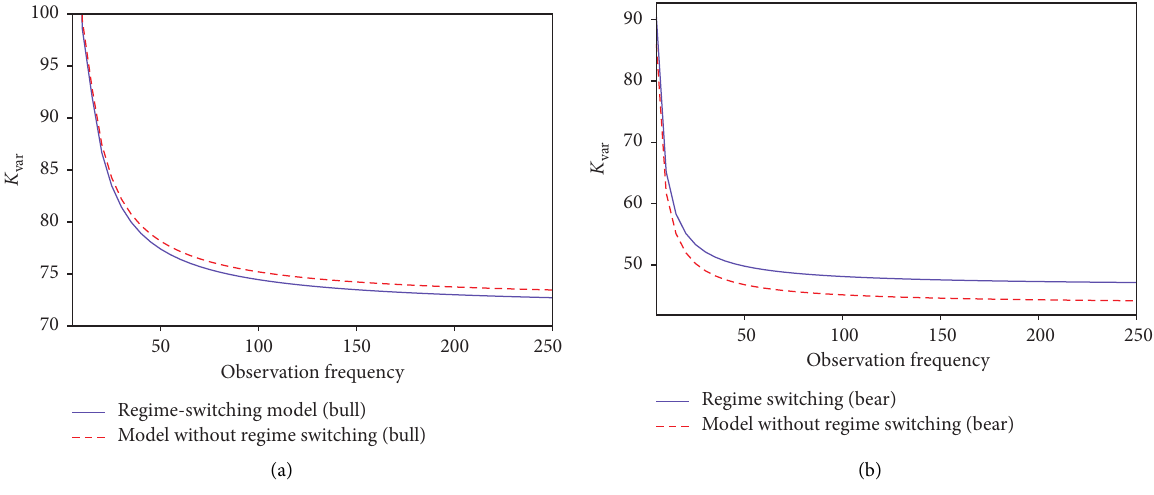
Figure 4: Comparison of K with and without regime switching: Kou-type jump. (a) Regime 1. (b) Regime 2. var